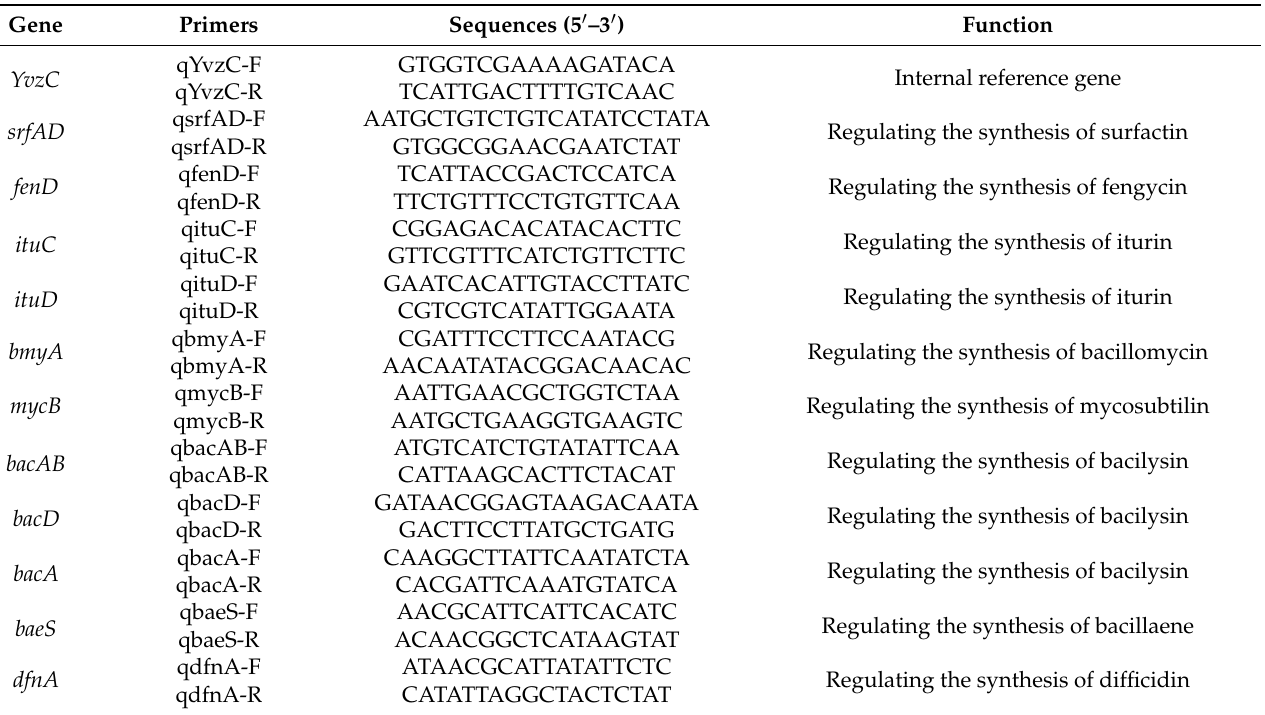
Table 2. Primers of genes related to antifungal substances in strain SBB for